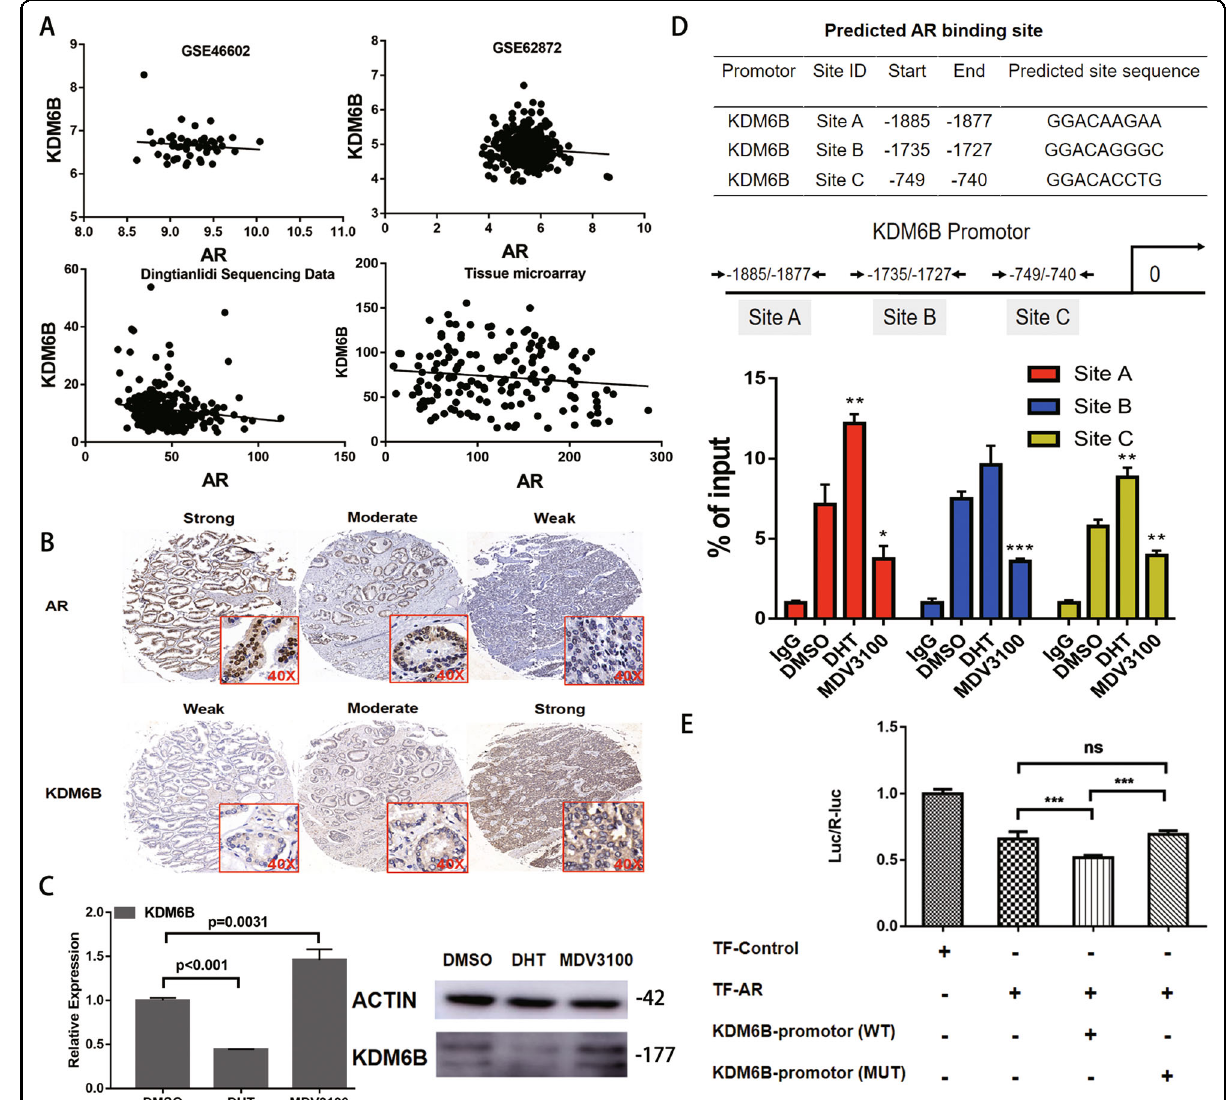
Fig. 5 KDM6B expression is downregulated by ARs. A A correlation analysis between KDM6B and ARs using data from GEO:GSE46602 ( n = 50, p = 0.83, r = -0.03), GEO:GSE62872 ( n = 424, p = 0.18, r = − 0.07), Dingtianlidi sequencing program ( n = 271, p = 0.02, r = − 0.18) and the tissue microarray ( n = 156, p = 0.33, r = − 0.08) was performed. B Representative images of the KDM6B and AR immunohistochemistry analysis indicate a negative correlation between KDM6B and ARs. C Comparisons of the KDM6B mRNA and protein expression levels among the DMSO, DHT, and MDV3100 treatments in the LNCaP cell line were performed by PCR and western blot analyses. Error bars means SD, n = 3 independent repeats. D Comparisons of the AR-binding levels to the KDM6B promoter among the DMSO, DHT, and MDV3100 treatments in the LNCaP cell line were performed using a ChIP-PCR analysis. Error bars means SD, n = 3 independent repeats. E Dual-luciferase reporter assay was used to verify that AR directly regulated KDM6B transcription by 3 ′ -UTR. Error bars means SD, n = 3 independent repeats (Note: AR, androgen receptor; DHT, dihydrotestosterone; MDV3100, enzalutamide; DMSO, dimethylsulfoxide) (ns: not signi fi cant, * p < 0.05, ** p < 0.01, *** p <